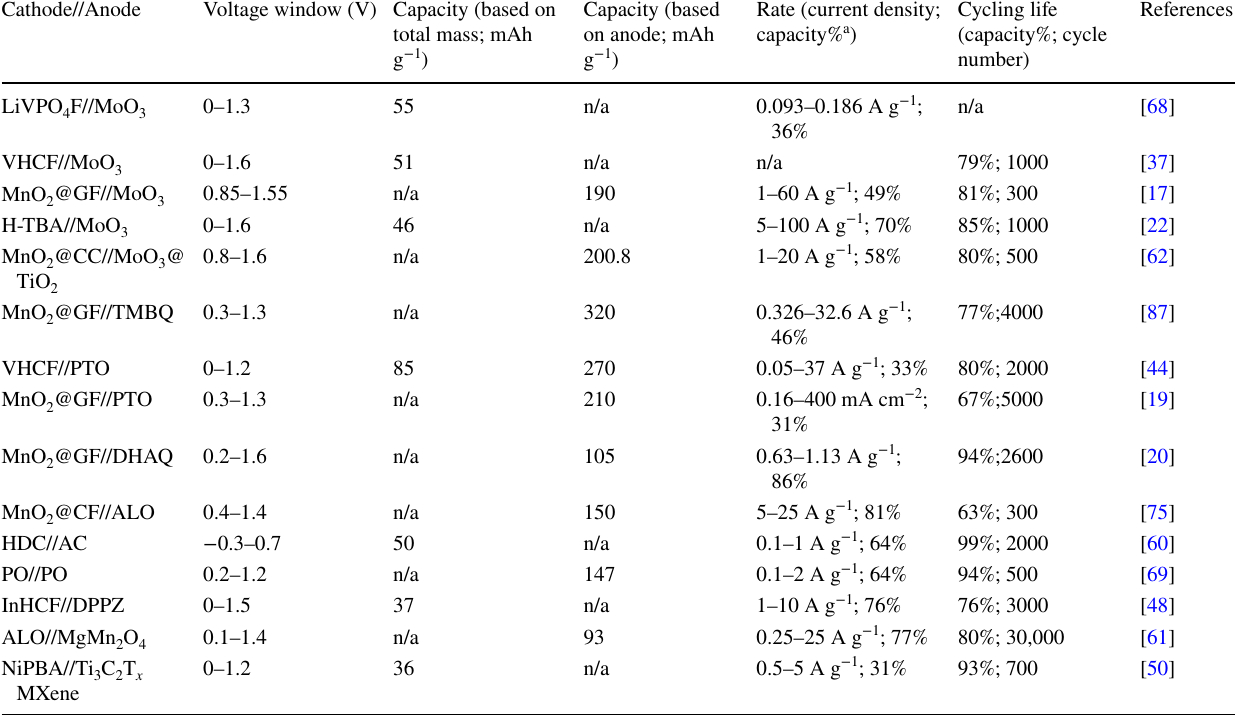
Table 1 A summary of voltage window, capacity, rate, and cycle life for proton-based full cells